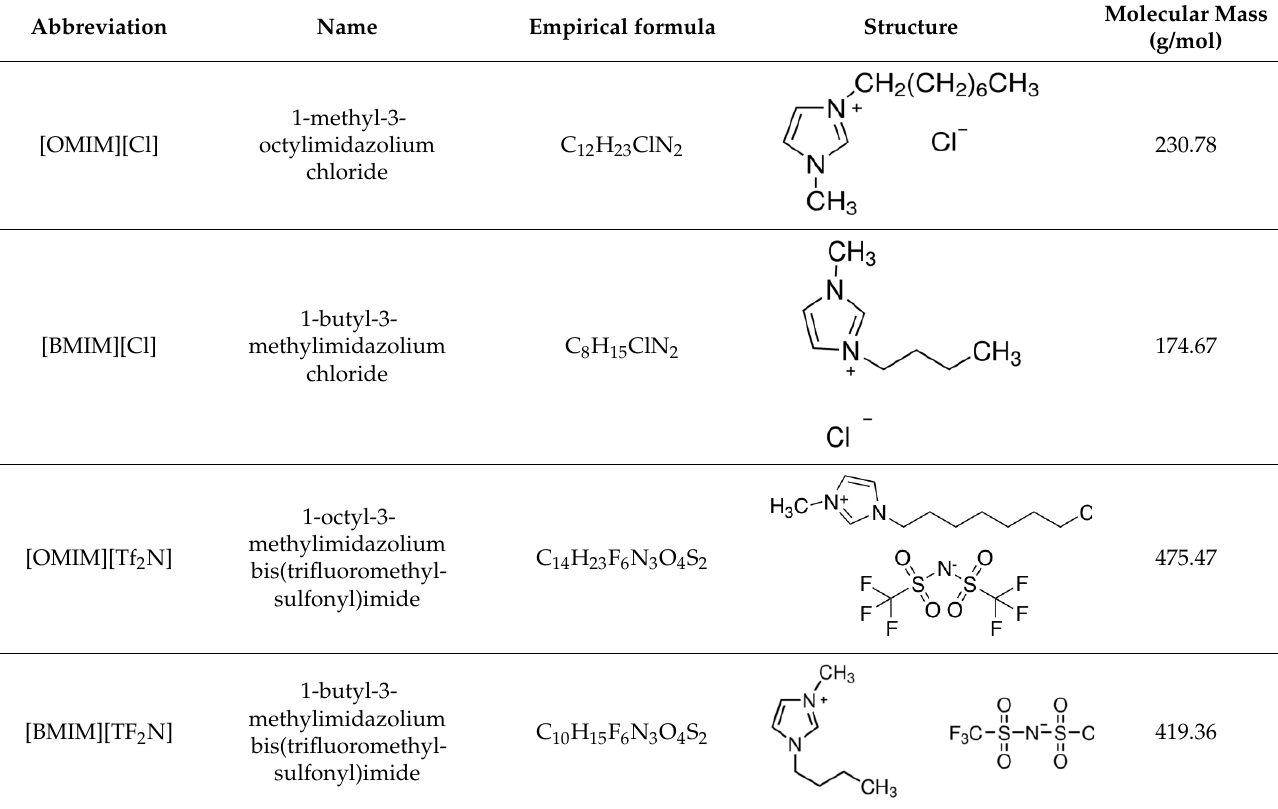
Table 3. Description of investigated neoteric solvents.